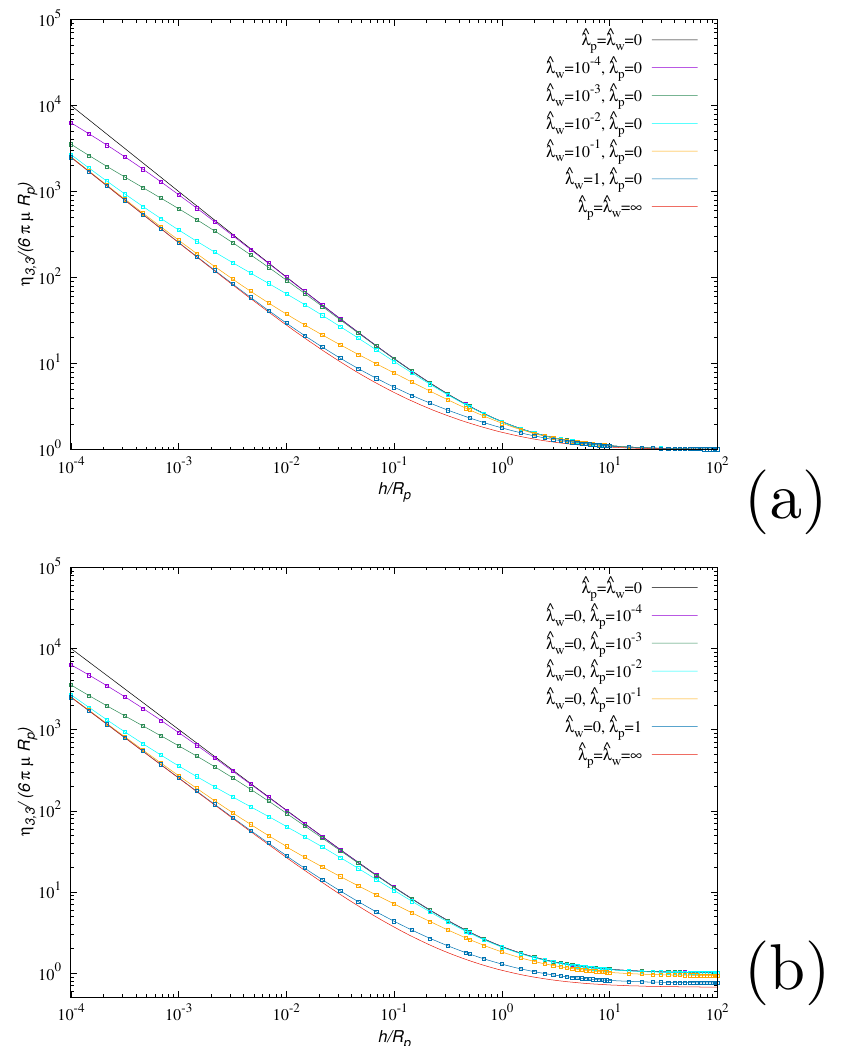
Figure 3. Dimensionless hydrodynamics resistance coefficient η 3,3 / ( 6 π µ R p ) vs h / R p in the case no-slip boundary conditions are imposed at the surface of the sphere ( a ) or at the wall ( b ). Each color in the panels corresponds to a different combination of slip lengths λ p , λ w as described in the inner legends. Continuous lines represent the results of the Goren’s equations, symbols the results of FEM